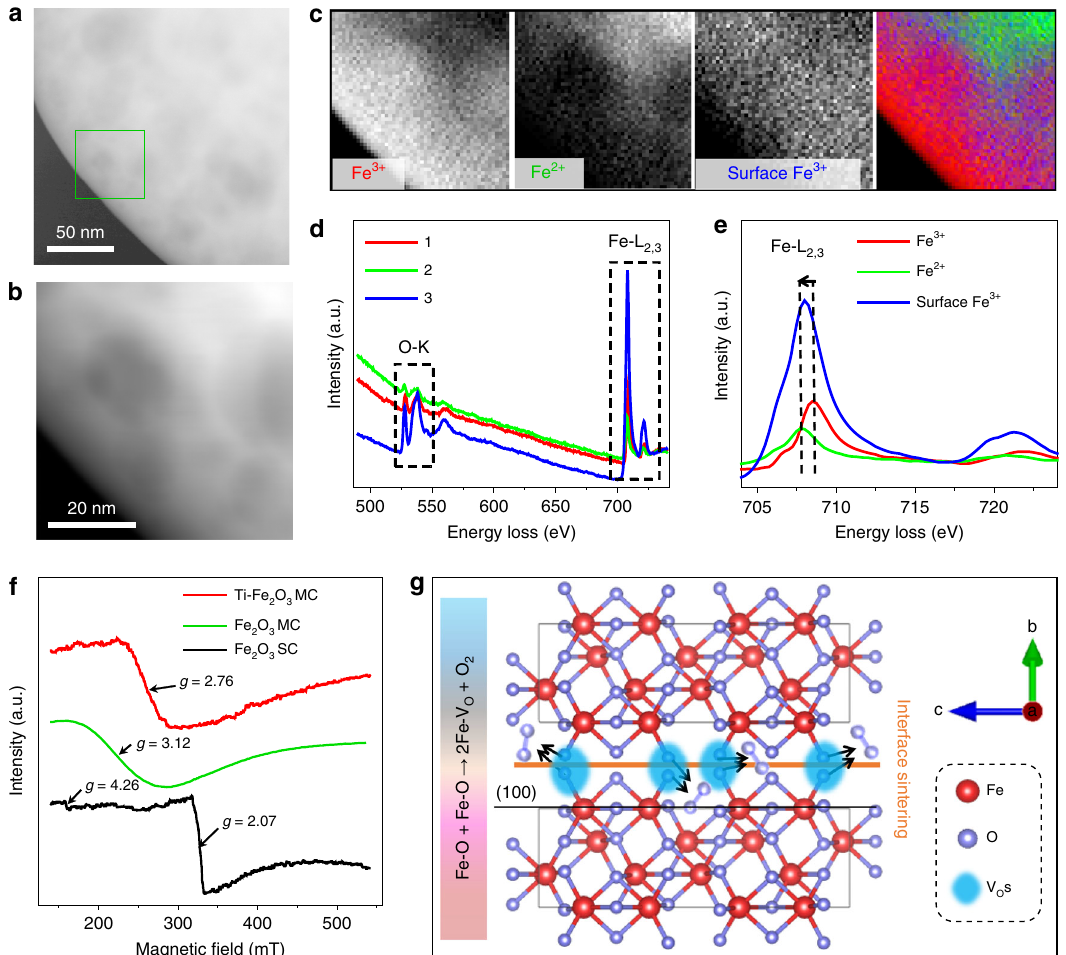
Fig. 2 Interfacial oxygen vacancies (V O ) in MCs. a , b HAADF-STEM images of Fe 2 O 3 MC and c corresponding EELS chemical composition maps of panel b . d EEL spectra of panel b and e corresponding EELS Fe-L 2,3 spectra of the selected region in panel b . The rightmost one of panel c is merged image of components 1 (red), 2 (green), and 3 (blue). f EPR spectra of the samples. g Schematic illustration of the V O formation in MC, where (100) facets are tentatively assumed to form the